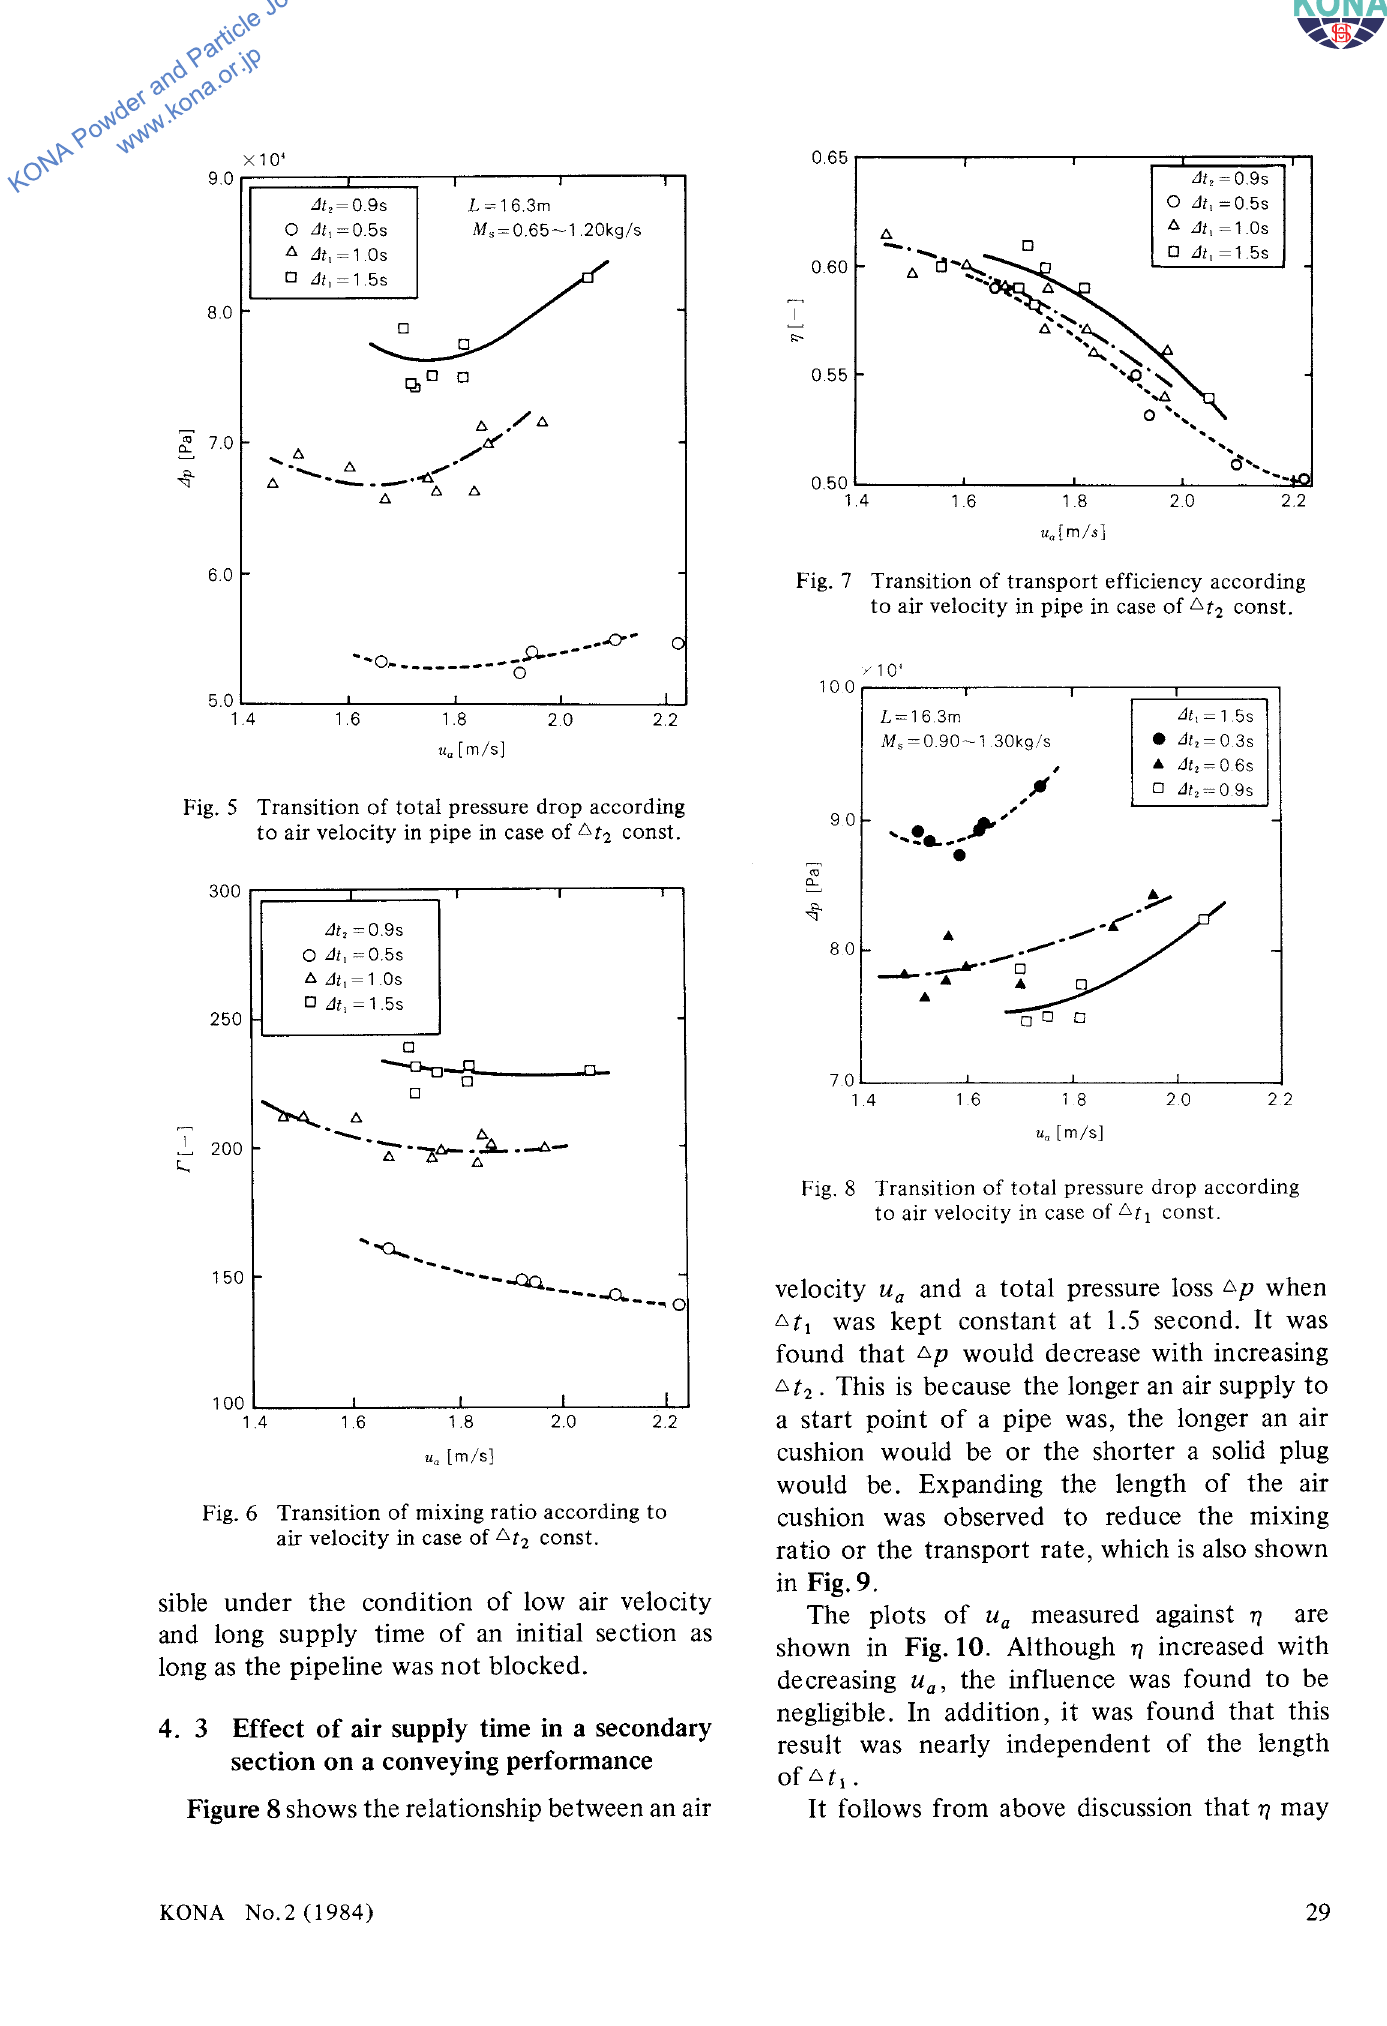
Fig. 7 Transition of transport efficiency according to air velocity in pipe in case of 6t2 const.